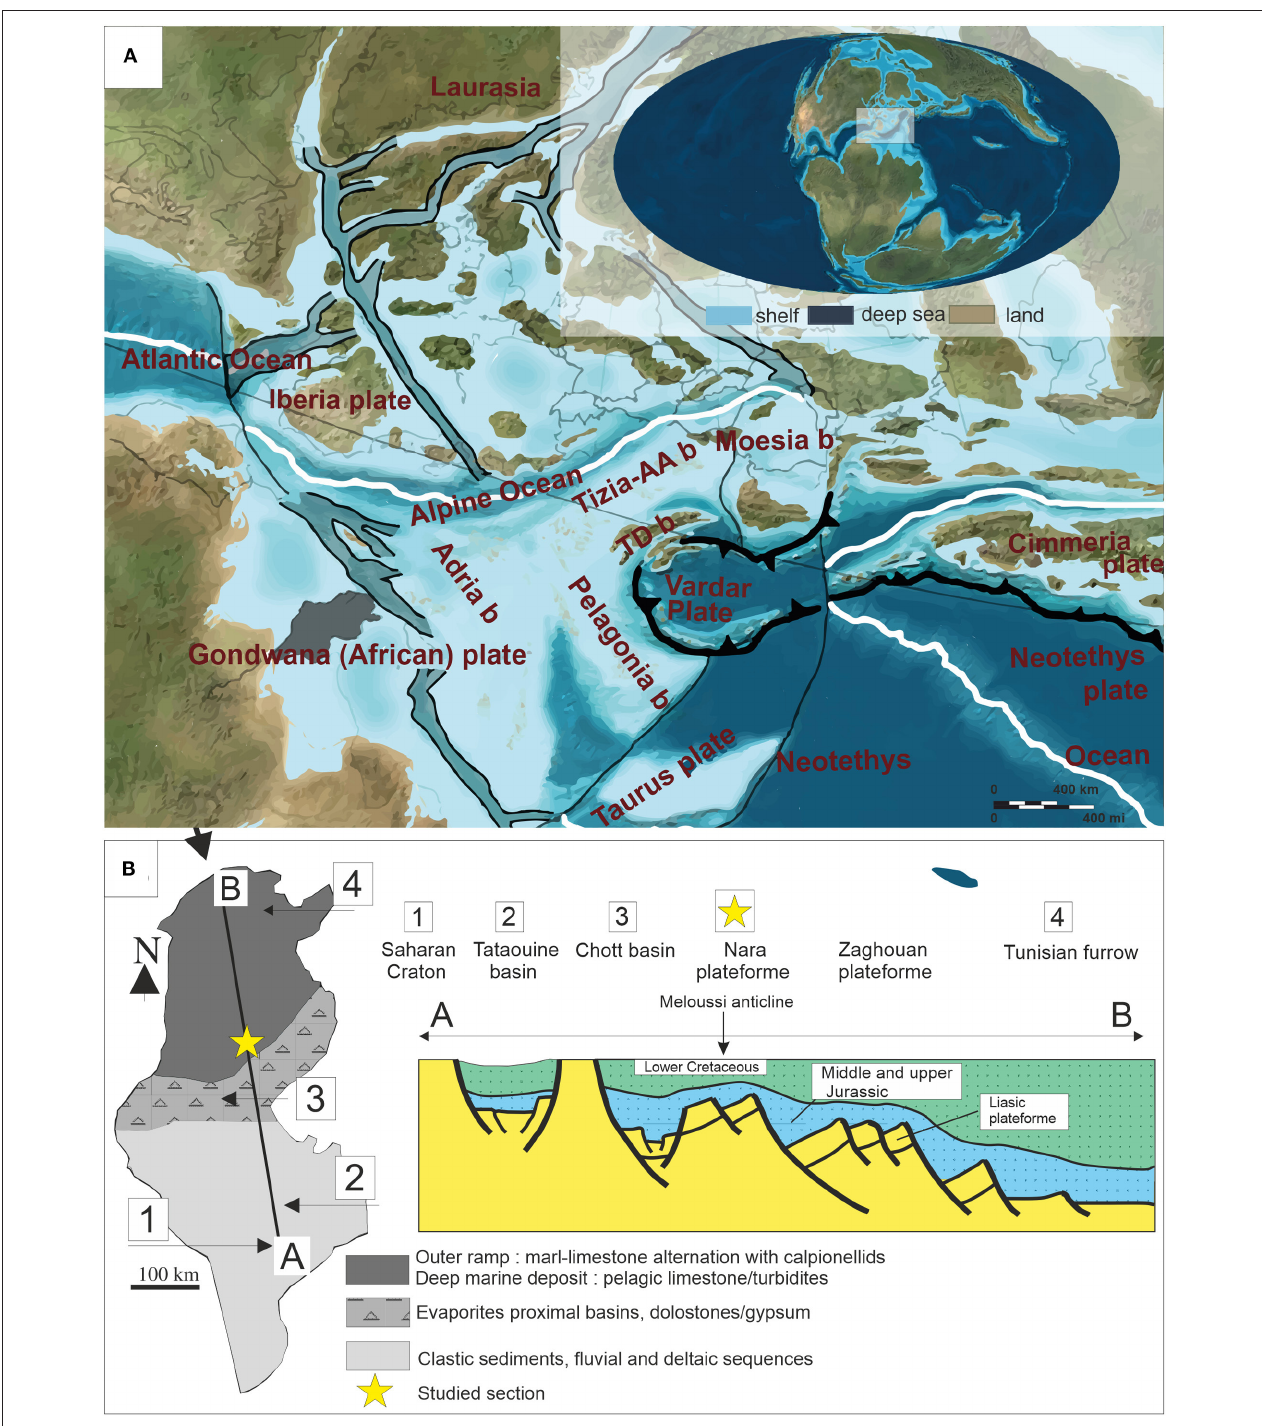
FIGURE 1 | Geologic and geographic setting of the study area. (A) Location of the study area within the Southern Tethys margin during the Late Jurassic (modified after R. Blakey, Colorado Plateau Geosystems, http://cpgeosystems.com/). (B) Late Tithonian paleogeography and facies distribution of Tunisia (modified after Soussi, 2002). The “AB” section shows the Jurassic and Early Cretaceous structural configuration of the Southern Tethys margin (Tunisia). Note the middle position of the Jebel Meloussi outcrop, between the continental saharan craton and the deep marine environments of the “Tunisian furrow” (modified after Soussi, 2002).